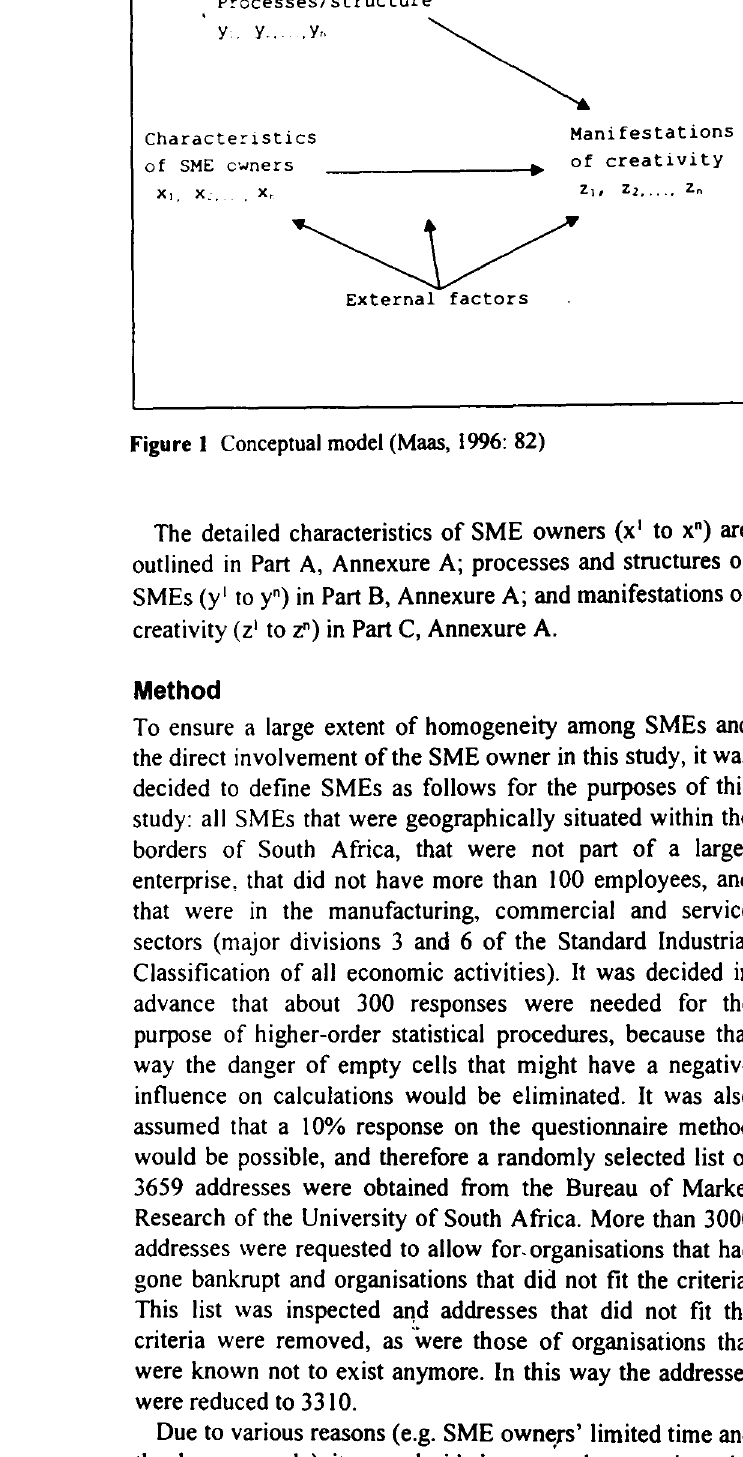
Figure I Conceptual model (Maas, 1996: 82)